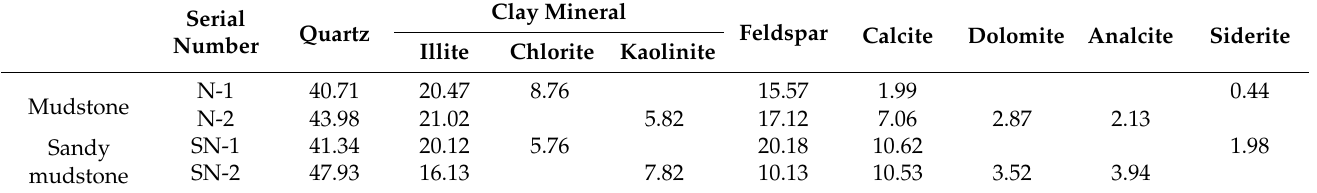
Table 1. Mineral composition of samples (according to the X-ray diffraction analysis of the